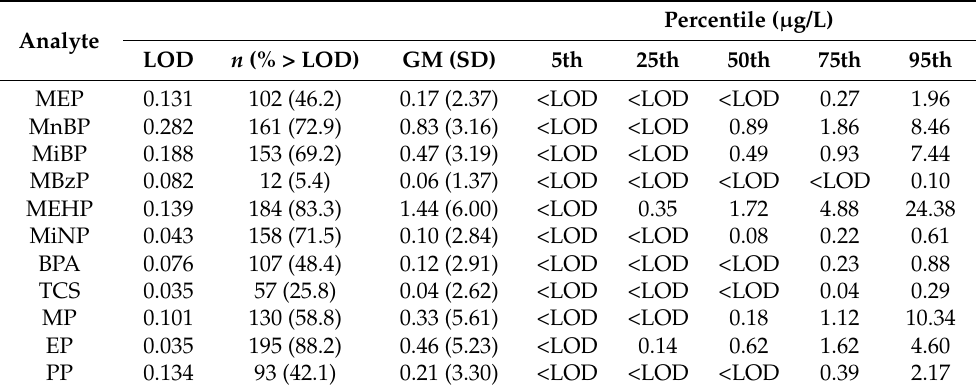
Table 2. Concentrations of phthalate metabolites, bisphenol A, triclosan, and parabens in the breast milk.